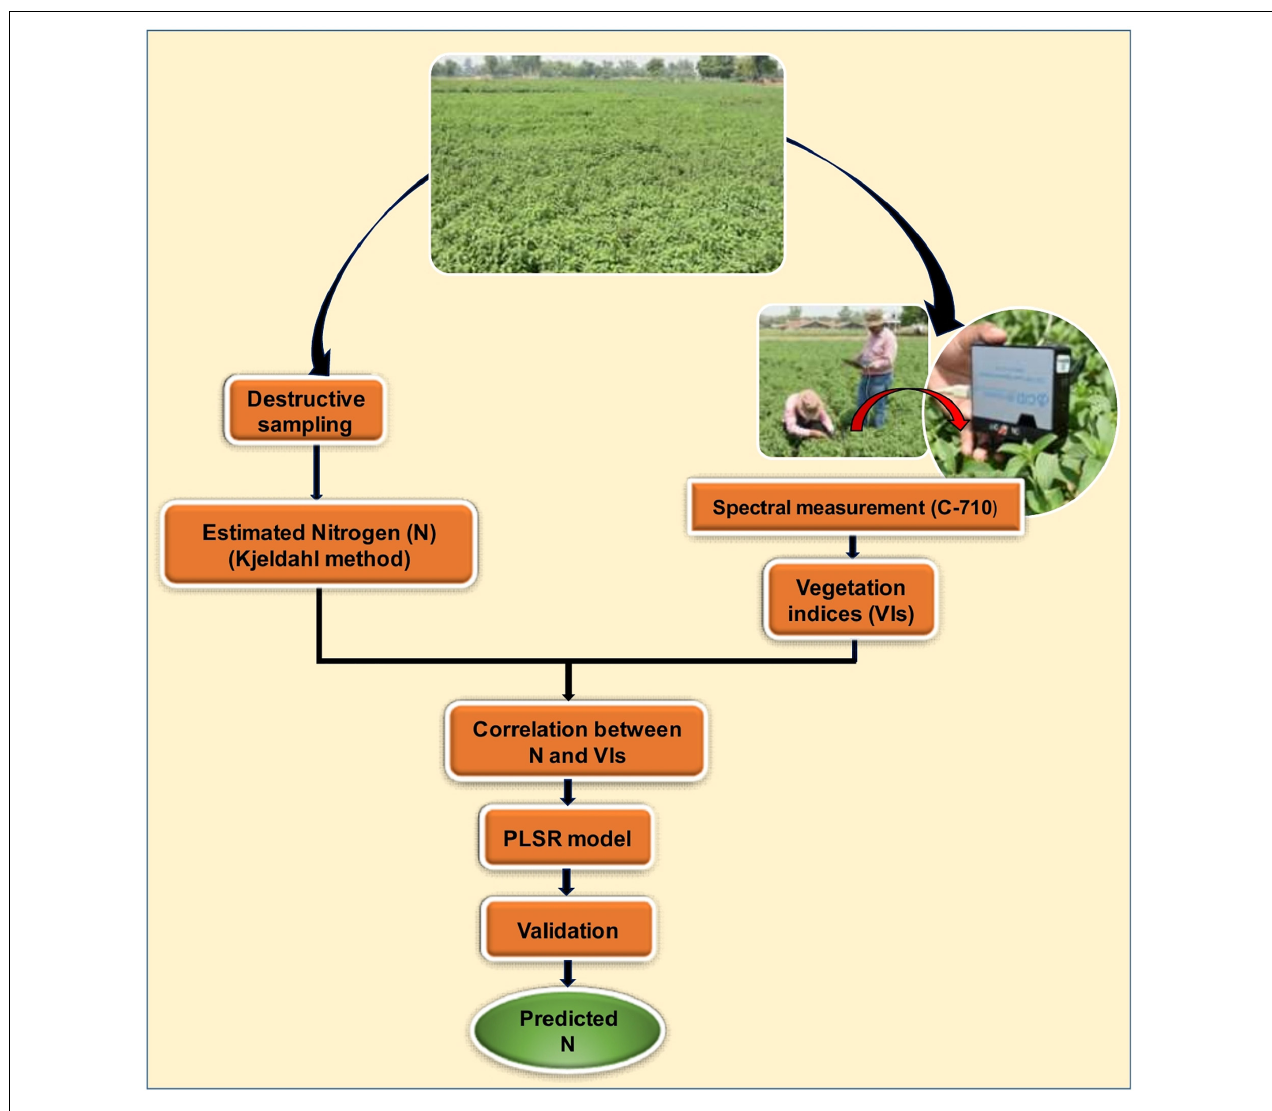
FIGURE 2 | Schematic representation of the methodology adopted in this study. TABLE 2 | Pearson correlation coefficient (r) between vegetation indices (VIs) and foliar nitrogen concentrations (N). NDRE